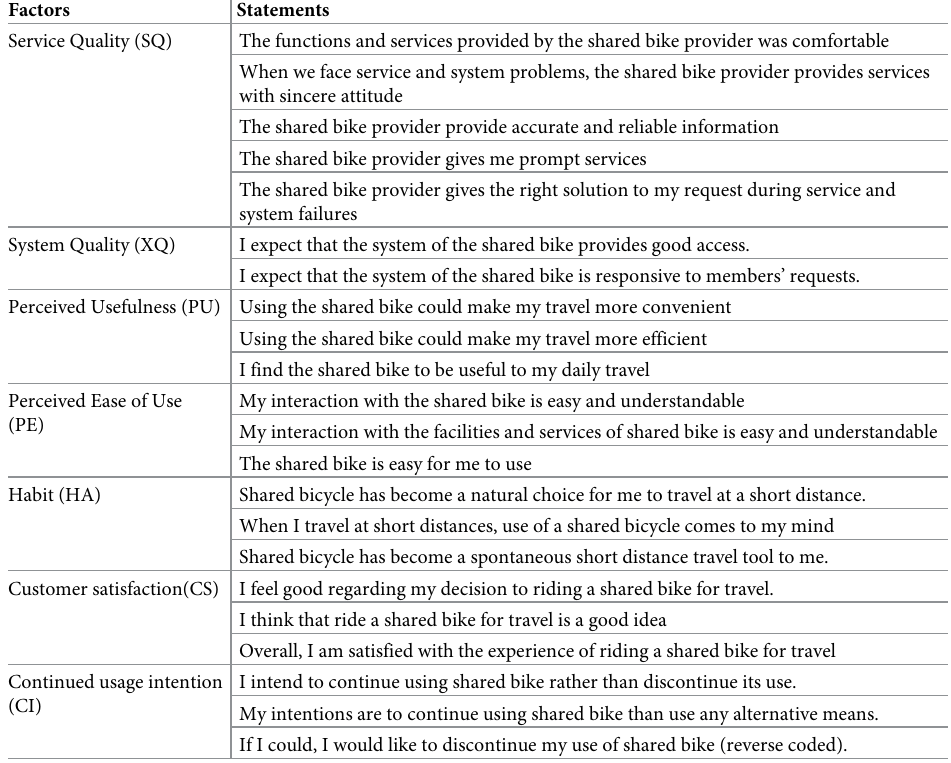
Table 1. Questionnaire statements for measuring usage